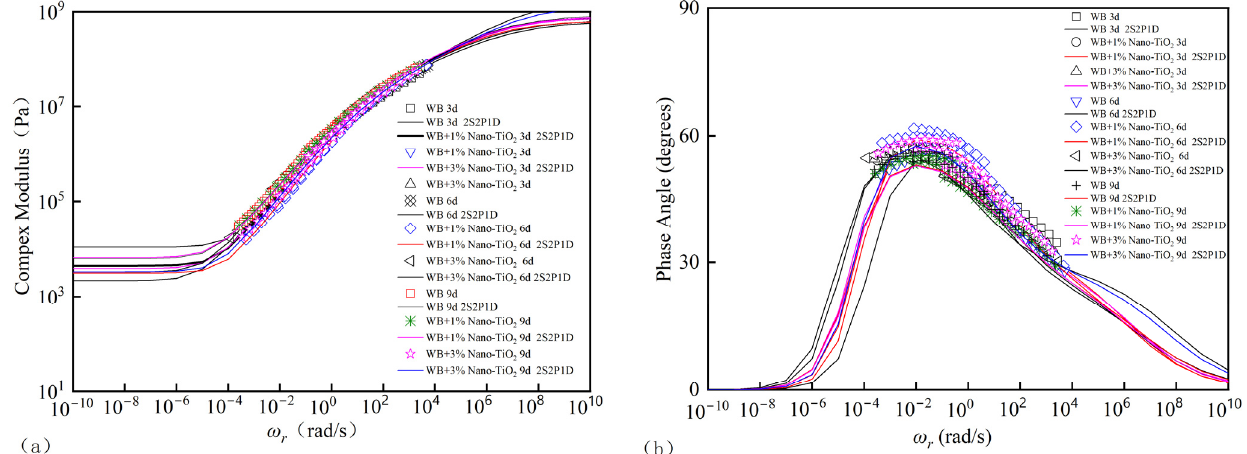
Figure 7. Master curves of viscoelastic parameters for UV-aged WB binder modified with various contents of Nano-TiO 2 at a reference temperature of 22 ◦ C ( a ) complex modulus; ( b ) phase angle.